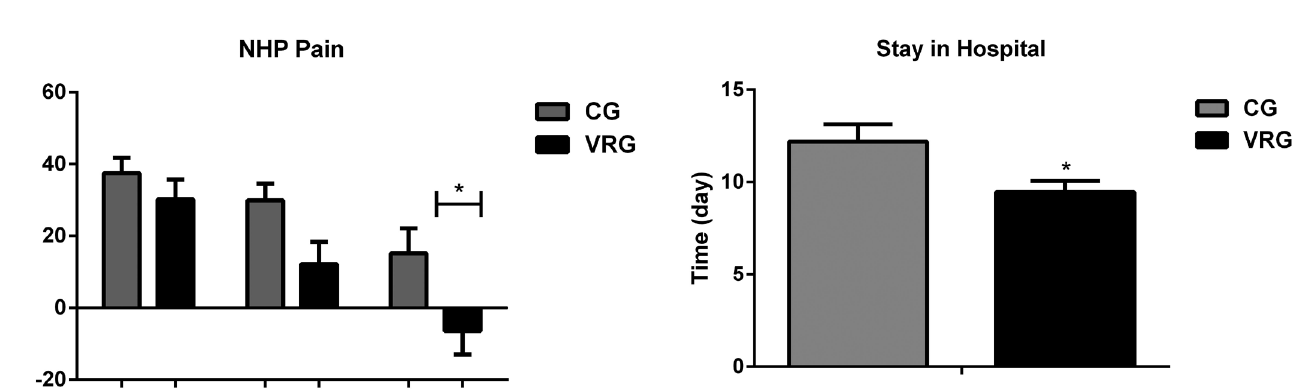
Fig. 6 - Total length of stay between CG and VRG. CG - Control Group; VRG - Virtual Reality Group; Data were analyzed using Student t test (*VRG x CG,